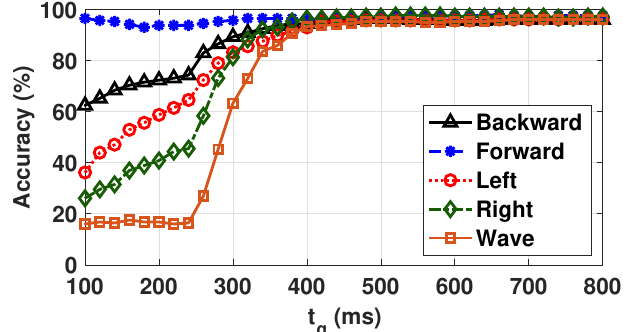
Figure 9. Accuracy of gesture recognition with the reduced NN for all